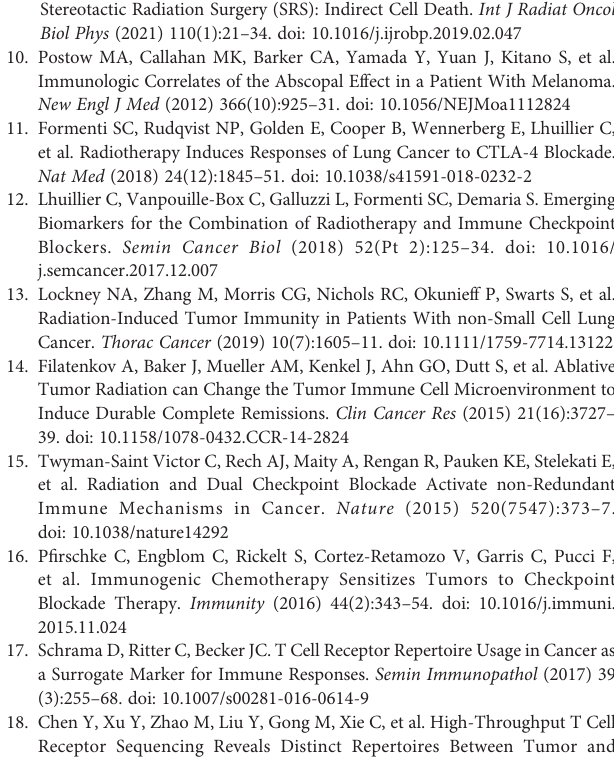
Supplementary Table 1 | Primers for TCR- b sequencing. Supplementary Figure 1 | TCR b sequencing of peripheral blood lymphocytes before and after stereotactic body radiotherapy (SBRT). Genomic DNA from peripheral blood mononuclear cell samples from 19 patients was quantitatively TCR- b -sequenced to compare T-cell clonality from before to after SBRT. Clones increasing in frequency are in blue, those decreasing in frequency are in red, and those with no signi fi cant change are in green. Supplementary Figure 2 | The new and loss TCR frequency during SBRT. Supplementary Figure 3 | Receiver operating characteristic curves for the Shannonindex.TheROCcurvesinpanels (A – C) showtheoptimalcutpointsforthe Shannon index in samples obtained at baseline (before SBRT) after SBRT, and the change between before and after SBRT (Dynamic). Dots indicate optimal cut-point values as well as sensitivity and speci fi city. Supplementary Figure 4 | Treatment outcomes versus numbers of unique clones. Boxplots in panels (A – C) show differences in clone counts in samples collected before stereotactic body radiation therapy (PreSBRT), samples collected after SBRT (PostSBRT), and the change between before and after SBRT (Dynamic) according to whether patients developed or did not develop distant metastases (DM) after SBRT. Kaplan – Meier survival estimates in panels (D – F) show progression-free survival curves for patients with clone counts above and below the identi fi ed cutpoints derived from baseline samples (PreSBRT), samples obtained after SBRT(PostSBRT), andthe change betweenbefore andafter SBRT(Dynamic). P values are derived from unadjusted log-rank